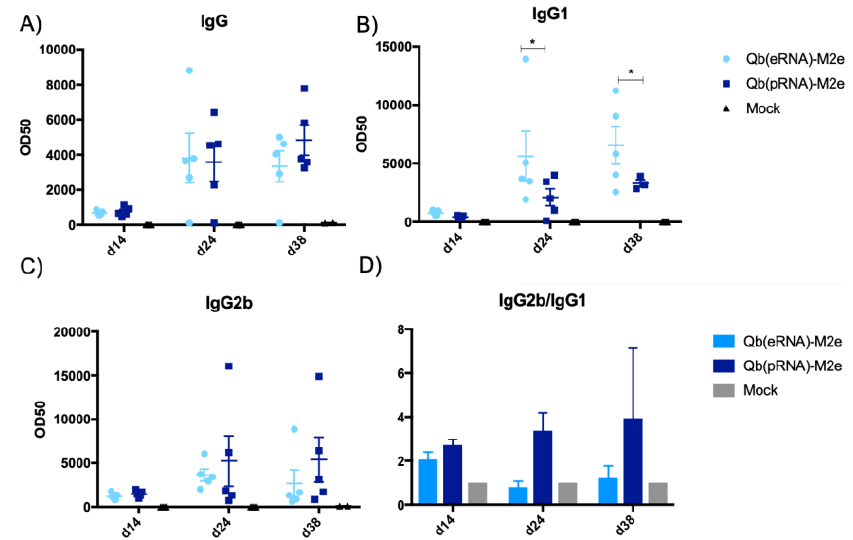
Figure 6. Humoral responses against M2e. Circulating levels of IgG, IgG1 and IgG2b measured on day 14, day 24 and day 38. Vaccine dose was 50 μg of VLP, injected s.c. Qβ(eRNA)-M2e induces significantly higher levels of antigen-specific IgG1 compared to the other vaccines (* p > 0.04) against VLP and M2. Ratios of IgG2b:IgG1 are represented as the ratio of the isotype geometric mean titres (OD50). Antibody data represented as mean + SEM, n = 5. Ratio represented by mean ratio of IgG2b/IgG1 + SEM. N =